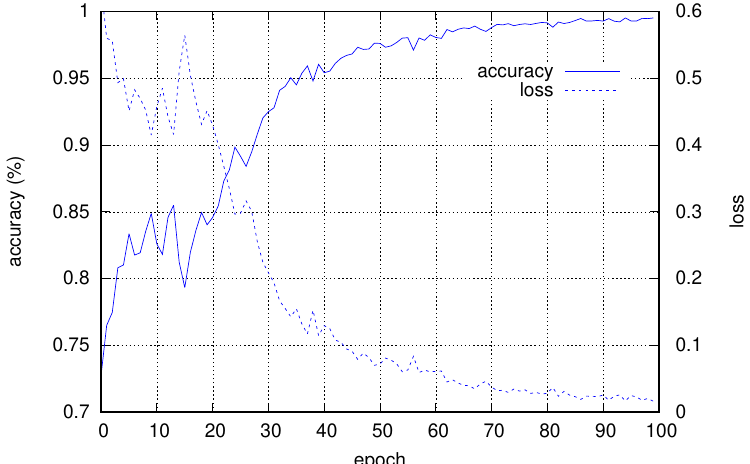
Figure 8. Accuracy and loss progress with respect to training epochs.